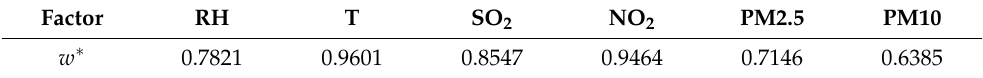
Table 7. The importance of each atmospheric factor in Stage 2 (after 2200 hours of exposure).